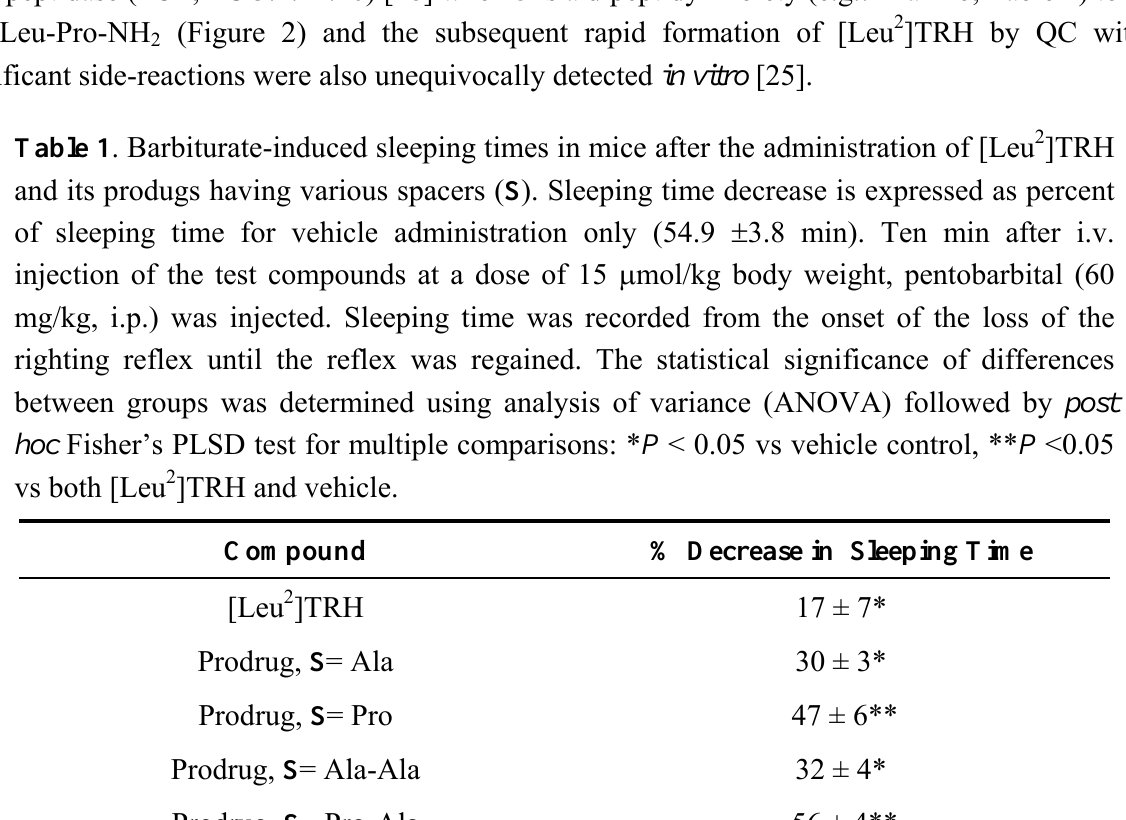
Table 1 . Barbiturate-induced sleeping times in mice after the administration of [Leu 2 ]TRH and its produgs having various spacers ( S ). Sleeping time decrease is expressed as percent of sleeping time for vehicle administration only (54.9 ± 3.8 min). Ten min after